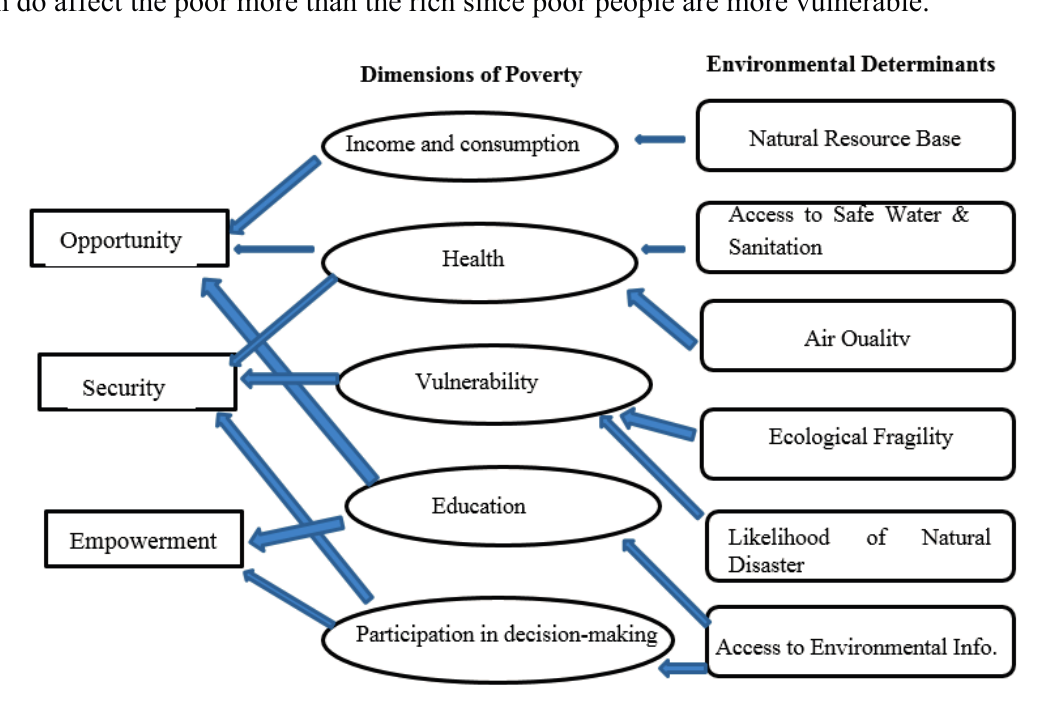
Figure 4. Environment-Poverty Linkages. Source: